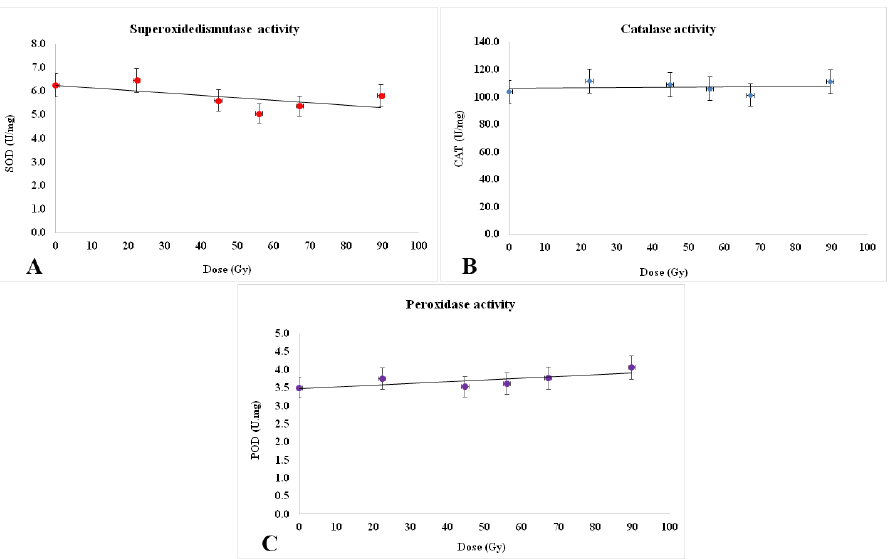
Figure 10. The activity of antioxidant enzymes in the samples corresponding to the proton irradiation at the Bragg peak. ( A ). Superoxidedismutase activity showed a slight but statistically significant decreasing tendency. ( B ). Catalase activity was found at approximately the same level in all samples. ( C ). Peroxidase was found to have a slight, statistically insignificant increase in the limits of standard deviation. Three repetitions of each enzyme assay were carried out for each experimental